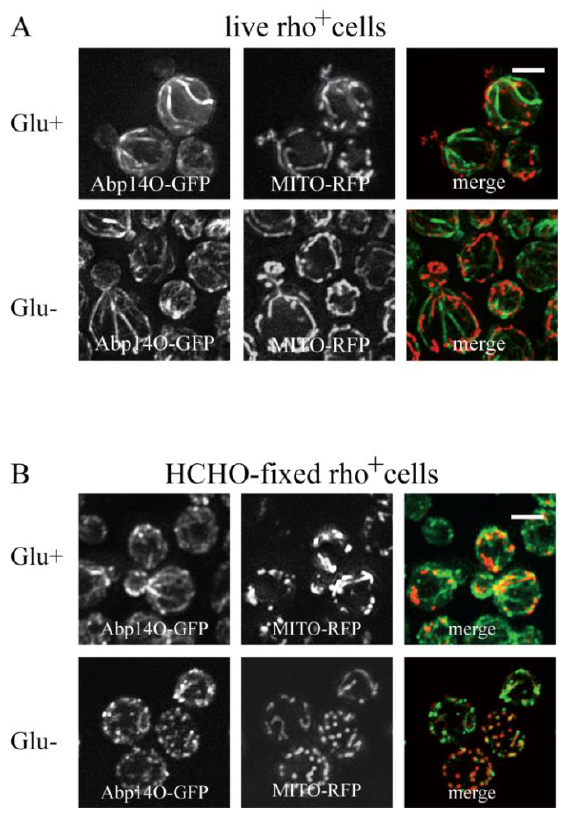
FIGURE 4: S. cerevisiae (rho + ) cells co-expressing Abp140-GFP and the mitochondrial marker MITO-RFP (strain CRY816). Expo- nentially growing cells were inspected as live cells (A) or after fixation with 3.7 % formaldehyde for 30 minutes (B) (HCHO- fixed). (Glu+) glucose was present in the medium; (Glu-) exponen- tially growing cells were shifted to glucose-free medium and in- cubated for 30 minutes before inspection or fixation. Distribution of fluorescent markers is presented after deconvolution and pro- jection of several image layers in the stack (Z-stack) using Xcel- lence software (Olympus). Bar, 5